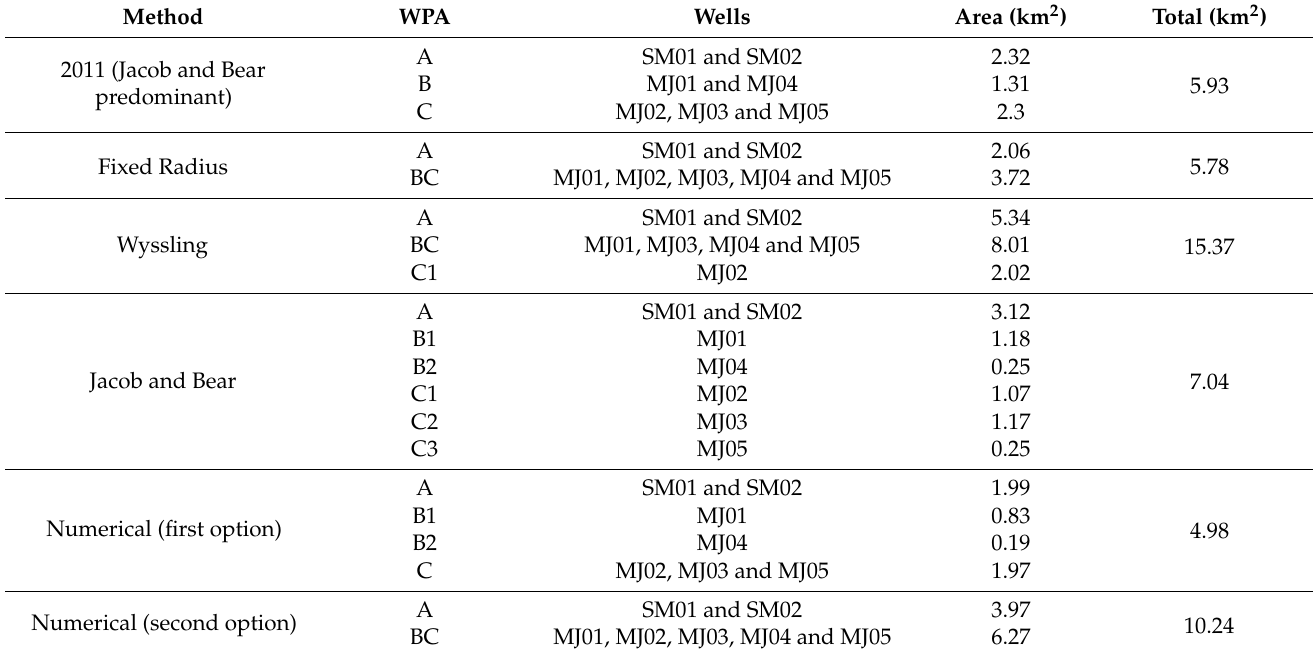
Table 4. Comparison of the areas occupied by the extended WPAs determined by the different numerical and analytical methods